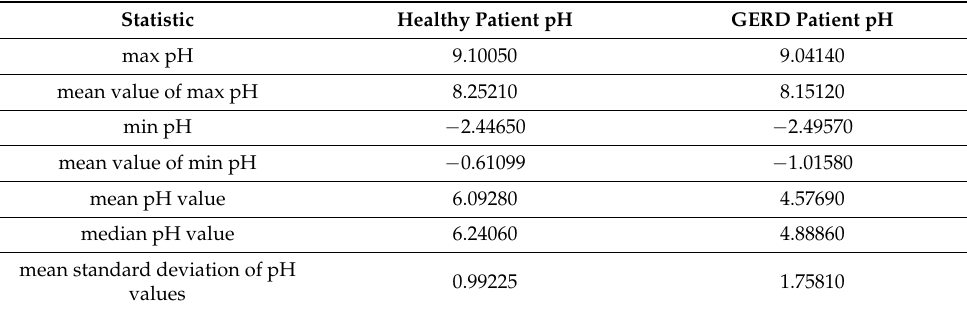
Table 2. Statistical analysis of esophageal pH measurements for healthy and GERD